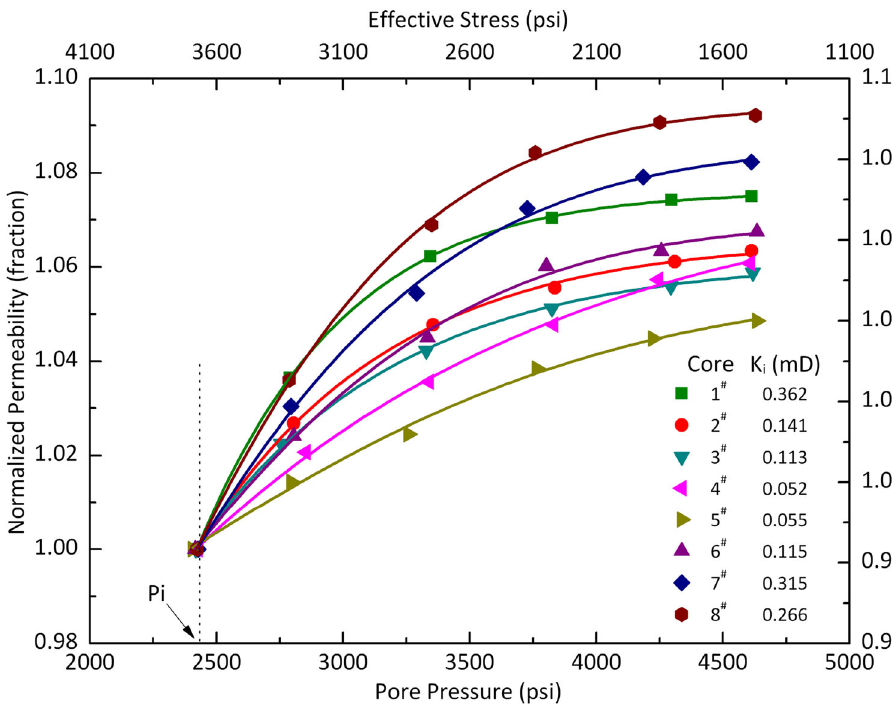
Fig. 1 Permeability